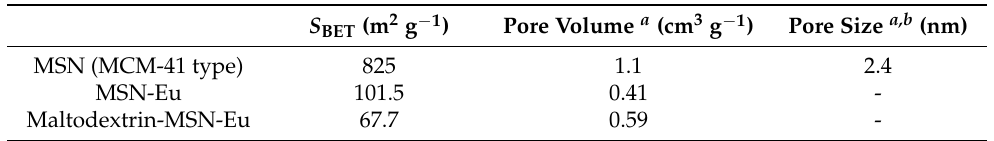
Table 2. BET-specific surface values, pore volumes and pore sizes calculated from the N 2 adsorption– desorption isotherms for selected